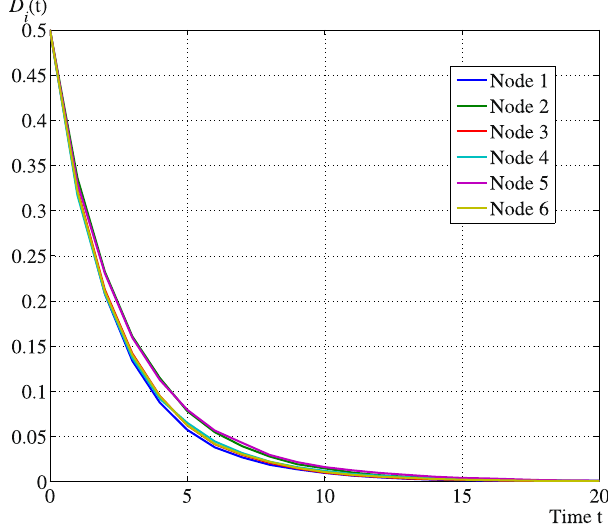
Figure 4. Trajectories